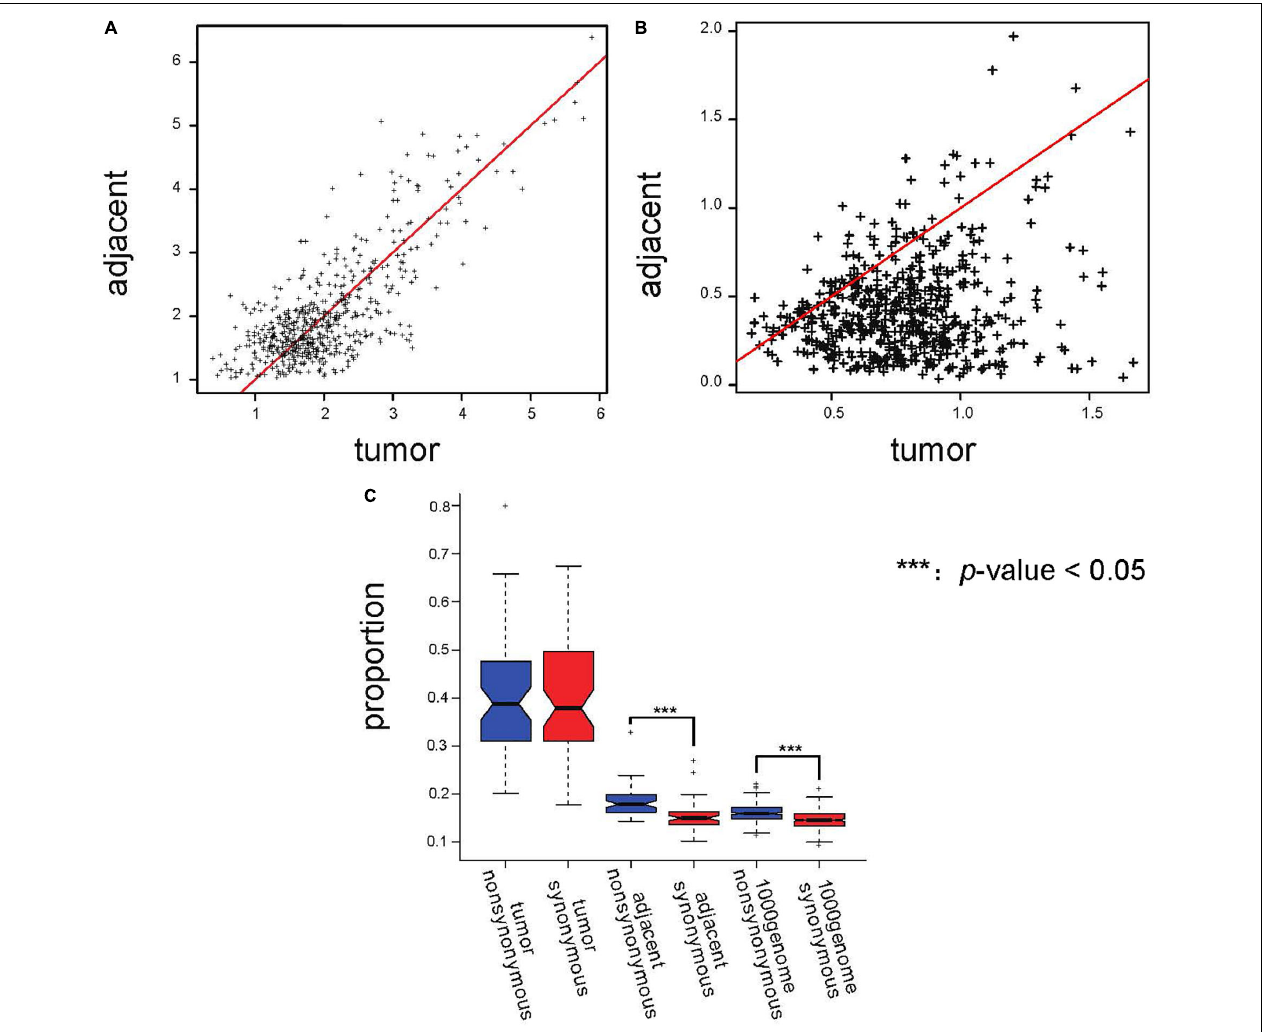
FIGURE 3 | Proportions of AEI in tumor samples did not show a stronger selection pressure; instead, they showed a stronger stochastic process. (A) Scatterplot of the average major/minor for the adjacent and cancer samples. The red line represents x = y. (B) Scatterplot of the major/minor coefficients of variation (CV) for the adjacent and cancer samples. The red line represents x = y. (C) A t -test analyzing the proportions of AEI in all expressed genes with synonymous (red) and non-synonymous (blue) SNPs in tumor samples, adjacent samples and 1000 Genomes data. In the tumor samples, no significant promotion of non-synonymous SNPs was